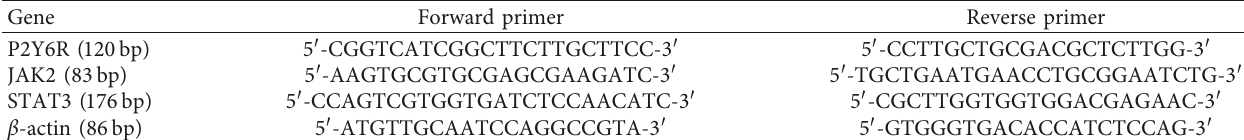
Table 1: Primer sequences for RT-PCR